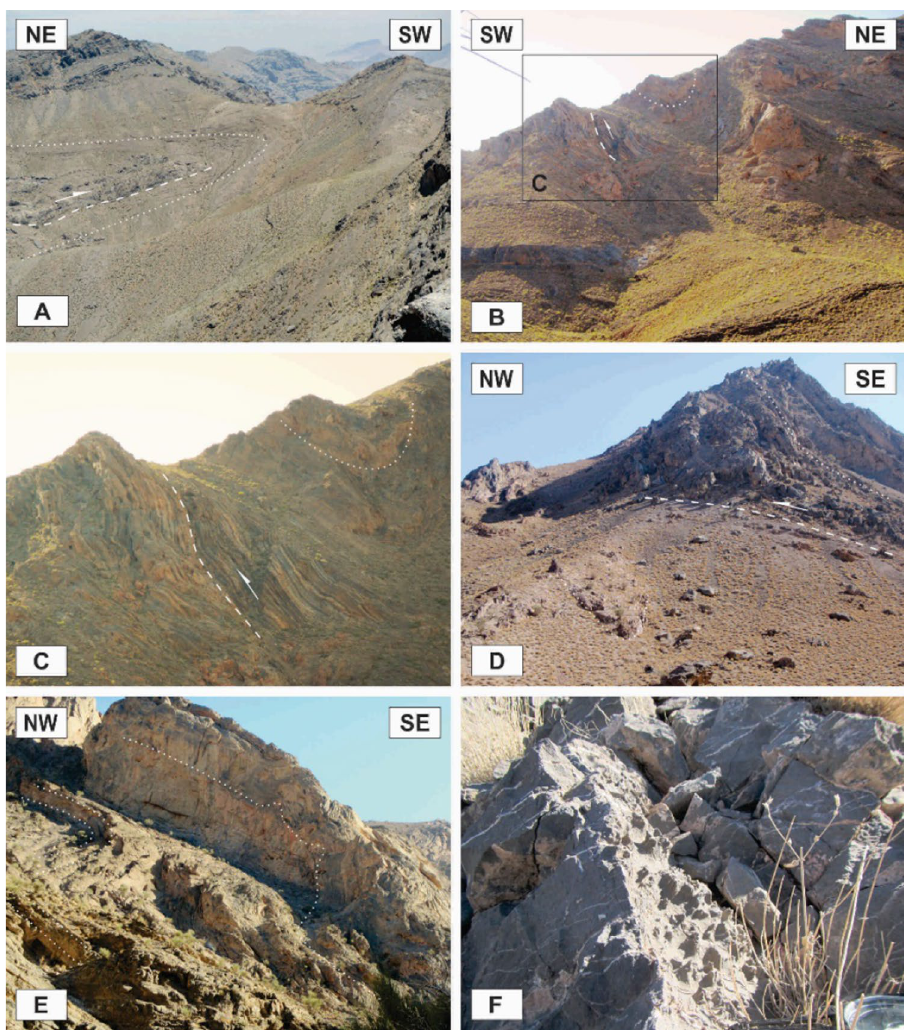
Figure 8. ( A–E ) Annotated field photographs of the several map-scale folds. ( F ) The tilted solution pits developed on the surfaces of the Permian limestone (P l ) layers in the Faryadoun Mountain. The compass needle is 55 mm long and toward N. (Photos are taken by Mohammad Ali